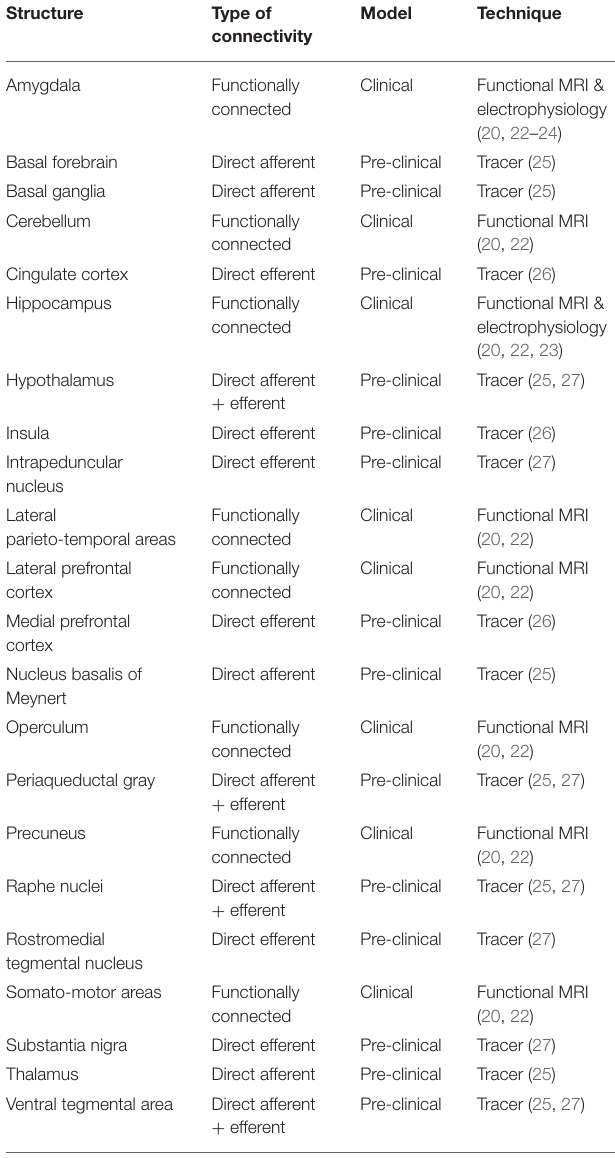
TABLE 1 | Connectivity of the